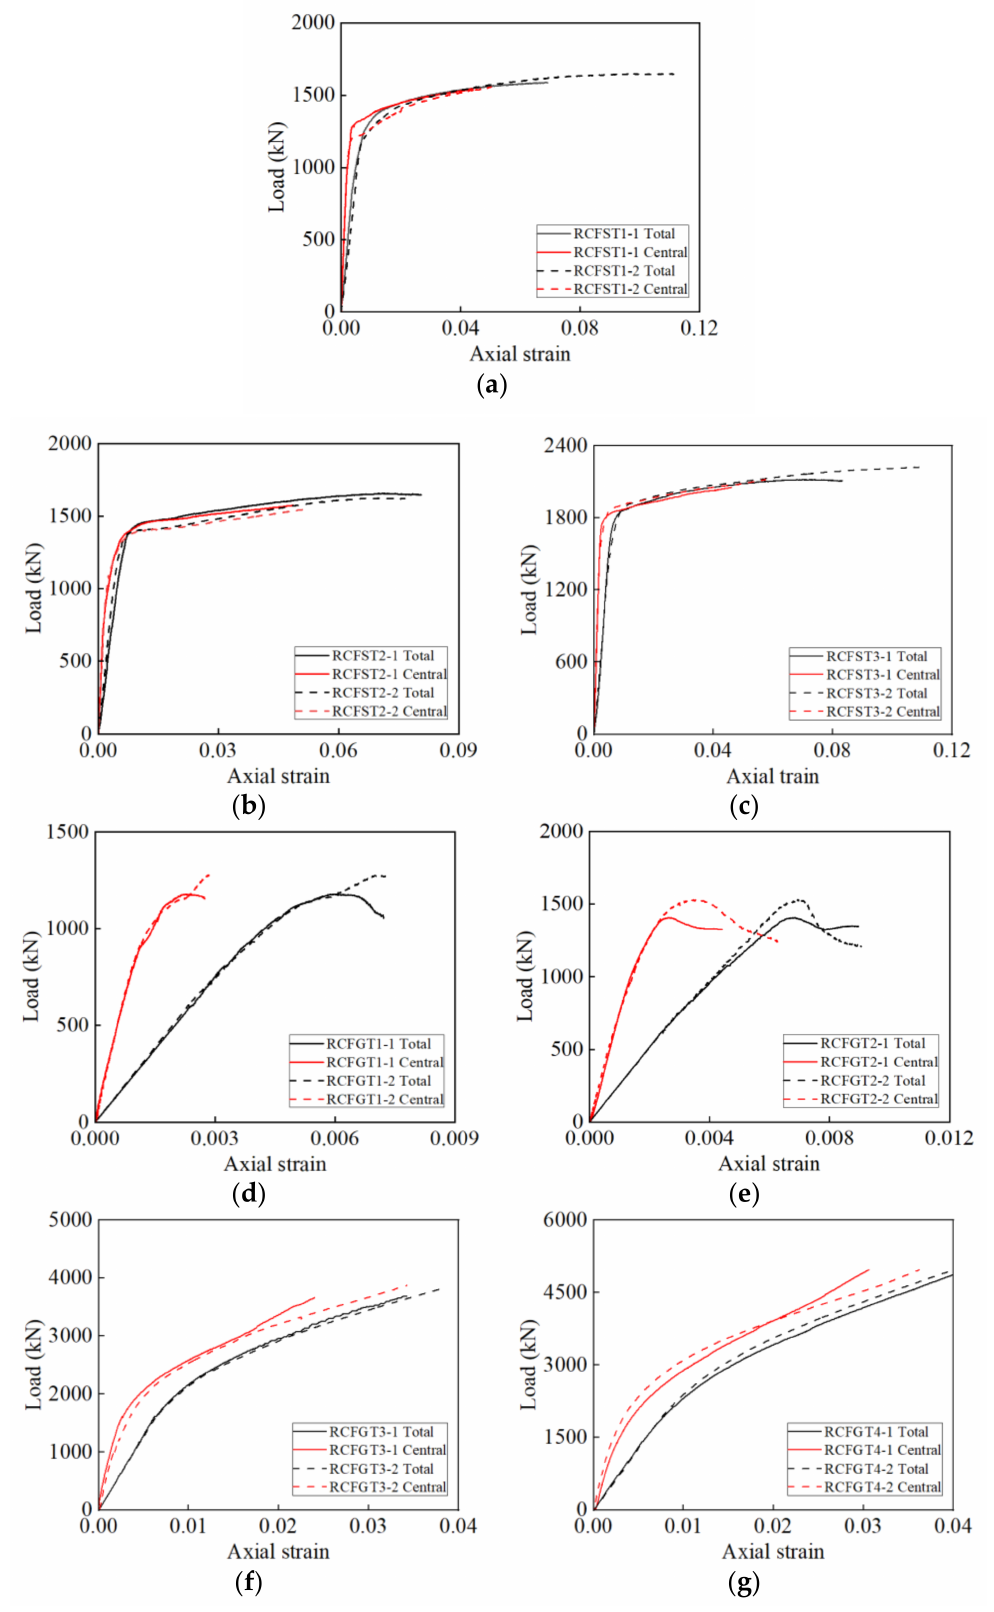
Figure 12. The load-axial strain curves. ( a ) RCFST1; ( b ) RCFST2; ( c ) RCFST3; ( d ) RCFGT1; ( e ) RCFGT2; ( f ) RCFGT3; ( g )